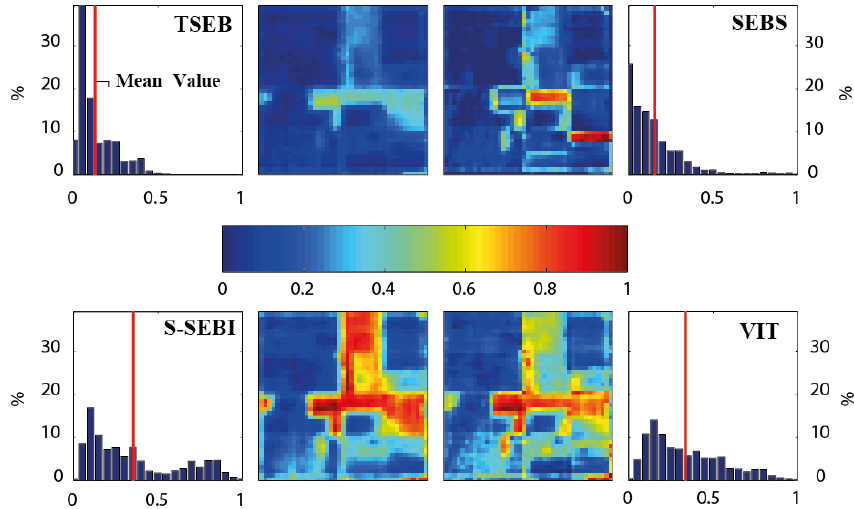
Fig. 10. Stress frequency histograms and maps for the whole area on 10